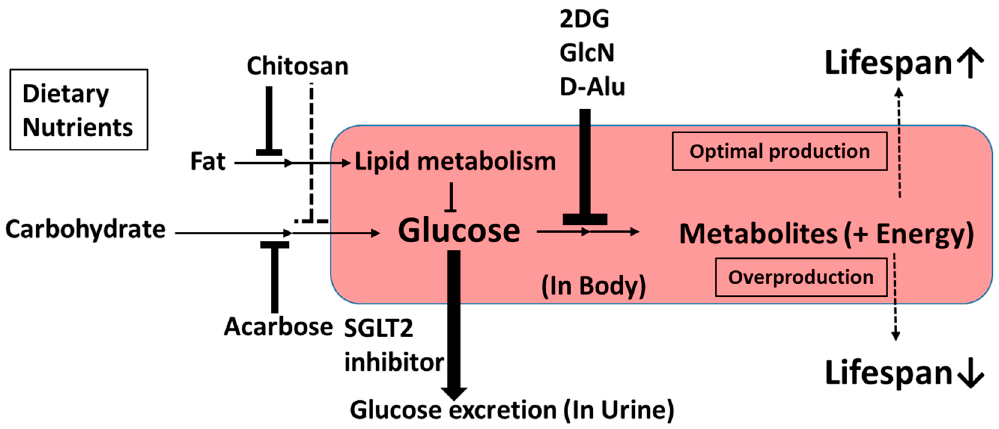
Figure 4. Characteristics of upstream-type CRMs.